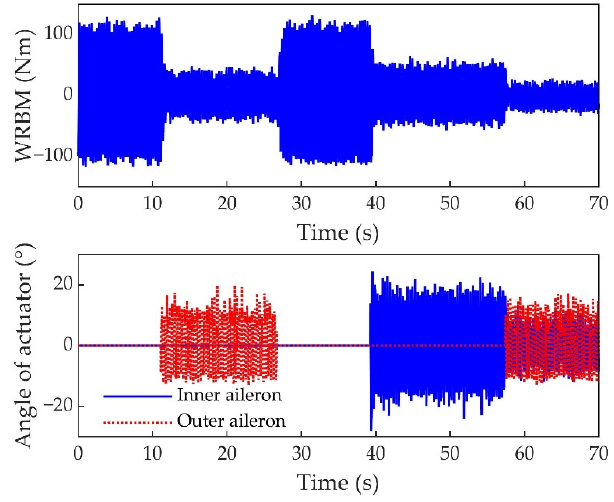
Figure 18. Gust response of WRBM and control surface deflection